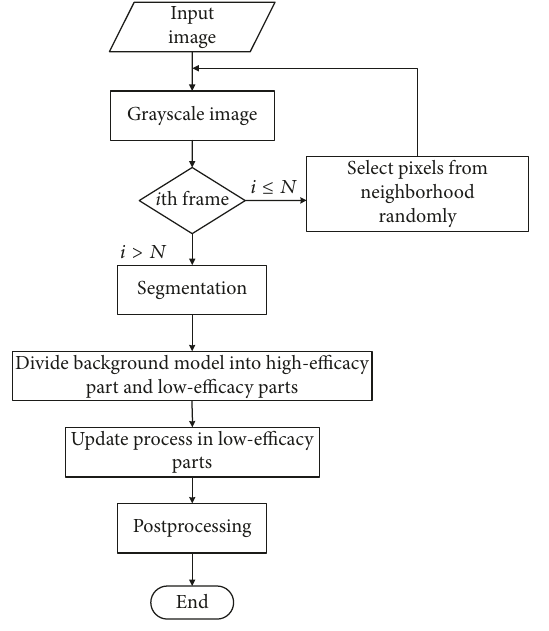
Figure 1: Diagram of the proposed